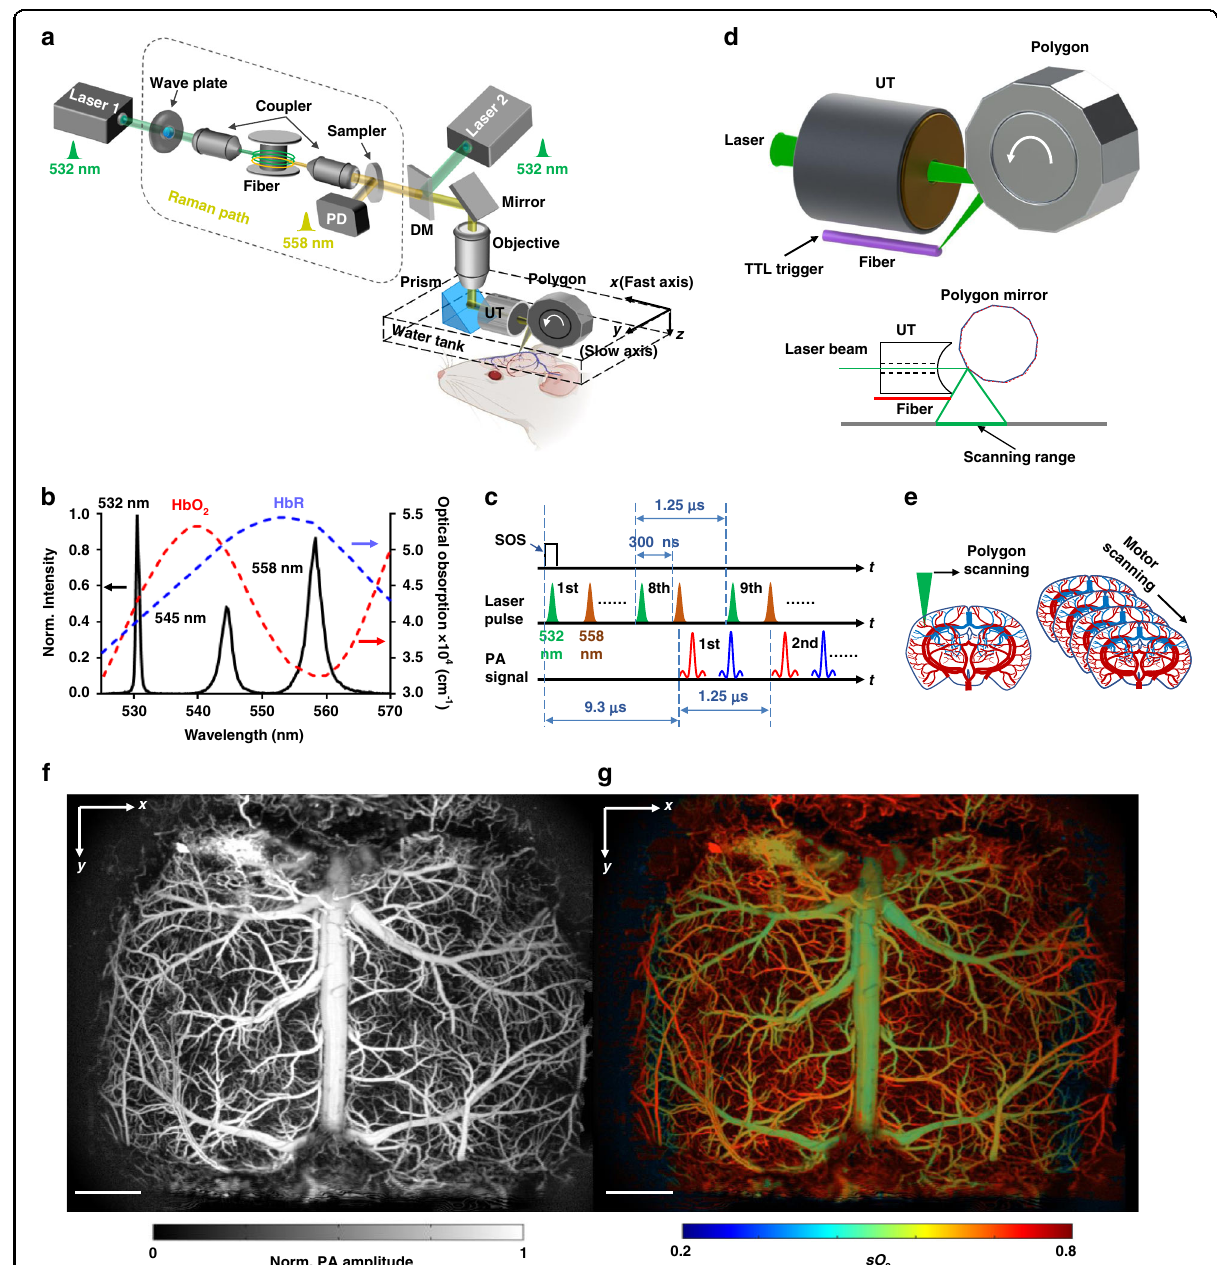
Fig. 1 Ultrafast functional photoacoustic microscopy (UFF-PAM) with high imaging speed and wide fi eld of view. a Schematic of the UFF- PAM system. The 532 nm light path and the 558 nm Raman path are combined for functional imaging. DM dichroic mirror, PD photodiode, UT ultrasound transducer. b The optical spectrum of the Raman path output, and the absorption spectra of oxyhemoglobin (HbO 2 ) and deoxyhemoglobin (HbR). c The dual-wavelength excitation sequence and the resultant PA signals from HbO 2 and HbR. d The close-up schematic of the ultrasound transducer, the polygon scanner, the start of scan (SOS) detection, and the scanning range. e Scheme of UFF-PAM scanning. Volumetric imaging is achieved by fast polygon scanning along the x axis (fast axis) and stepper motor scanning along the y axis (slow axis). f A representative x – y maximum amplitude projection (MAP) image of a mouse brain vasculature over the entire cortex, acquired by UFF-PAM at 532 nm. g The oxygen saturation of hemoglobin (sO 2 ) map of the same mouse brain, acquired with dual-wavelength measurements at 532 nm and 558 nm. Scale bar in ( f , g ), 1